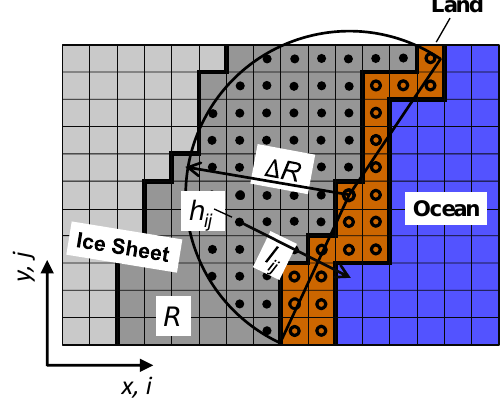
Figure 1. Principle sketch of the discharge parameterization over a part of the horizontal computational domain. The gray shading shows the ice-covered cells, while the dark gray shaded area R in- dicates the region over the ice sheet where the discharge parameter- ization applies. The (half) circle illustrates how that band R with the width of about (cid:49)R is determined in our scheme. Namely, the centre of such a circle is applied to every land point (open circles over the brown area). The smallest distance to the ocean l ij is depicted here for one example ice grid point. It is determined for every grid point inside the band R . For the discharge parameterization, the ice thick- ness h ij and the smallest distance to the ocean l ij are evaluated at grid points (i,j) , see Eq.